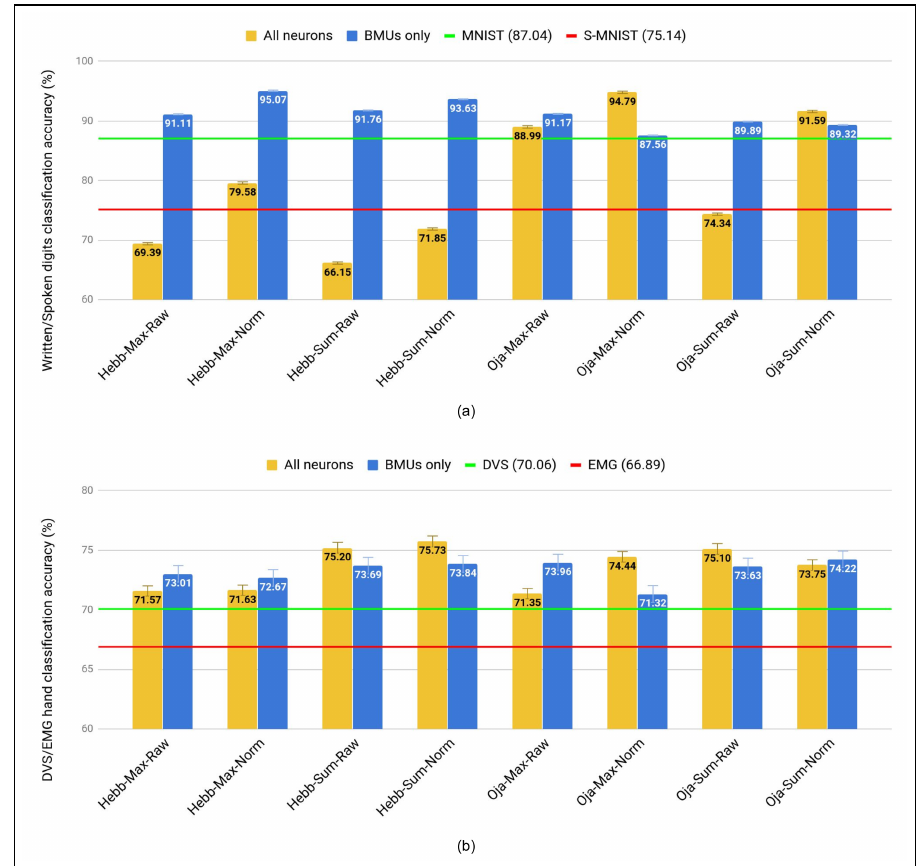
Figure 7. Multimodal convergence classification: ( a ) Written/Spoken digits; ( b ) DVS/EMG hand gestures. The red and green lines are respectively the lowest and highest unimodal accuracies. Hence, there is an overall gain whenever the convergence accuracy is above the green